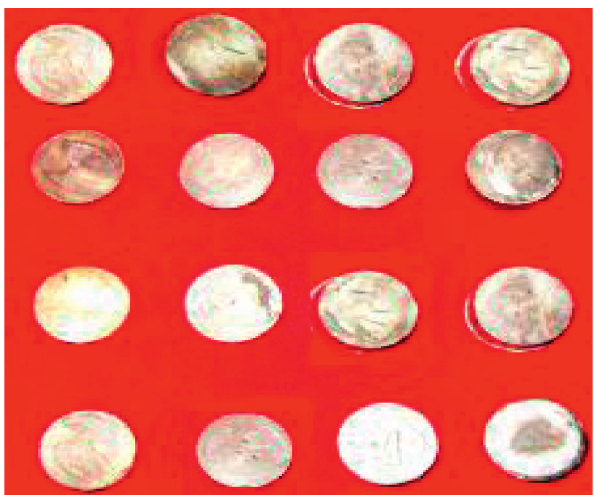
Figure 4: Image of Vickers microhardness test